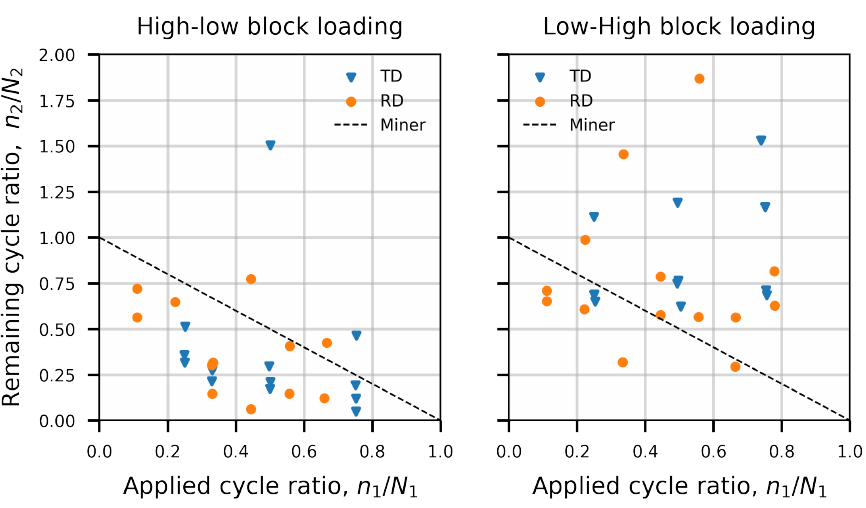
Figure 7. H–L ( left ) and L–H loading ( right ) experimental results. The dashed line corresponds to Palmgren–Miner’s rule. A distinction is made between specimens extracted from the transverse (TD) and rolling direction